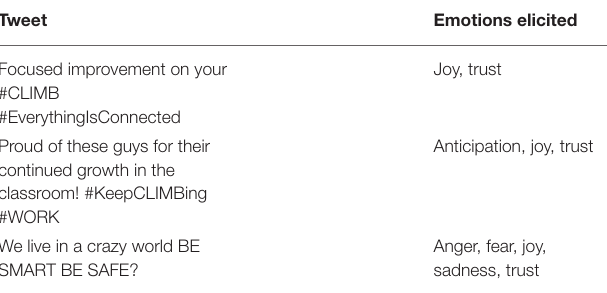
TABLE 2 | Examples of emotions elicited corresponding to respective